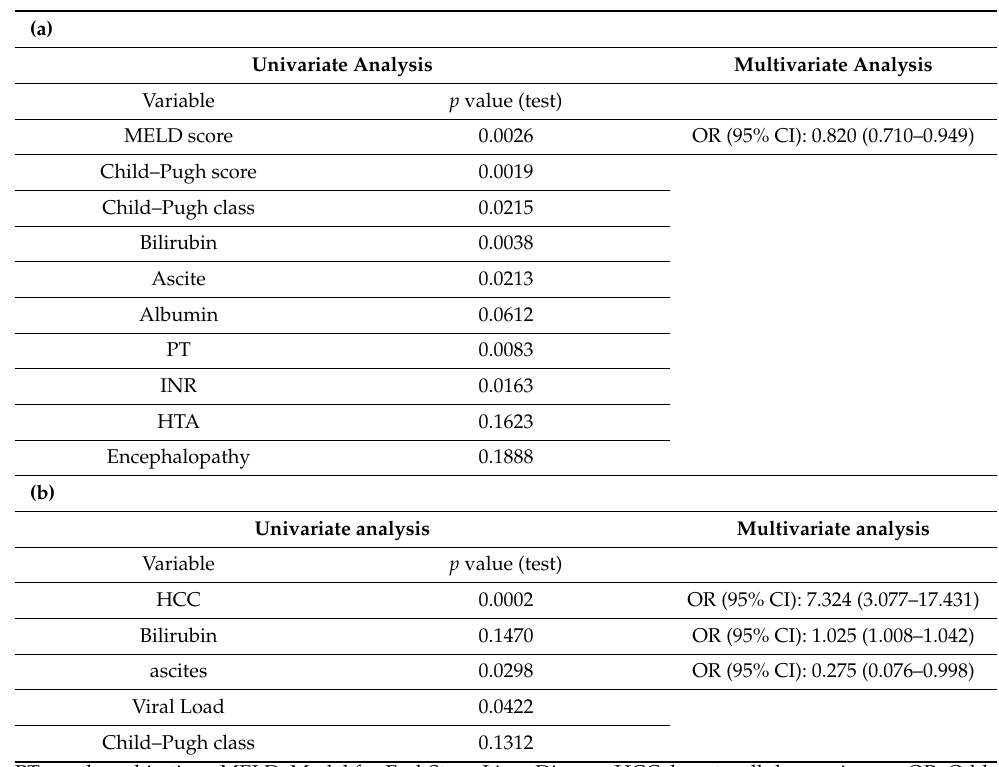
Figure 3. ROC curve for Child–Pugh score ( A ) and ROC curve for MELD score ( B ) to predict delisting after HCV treatment for an improvement in patients awaiting LT for decompensated cirrhosis. Table 3. Predictive factors for delisting for an improvement in decompensated cirrhosis (a) and predictive factors for liver transplantation